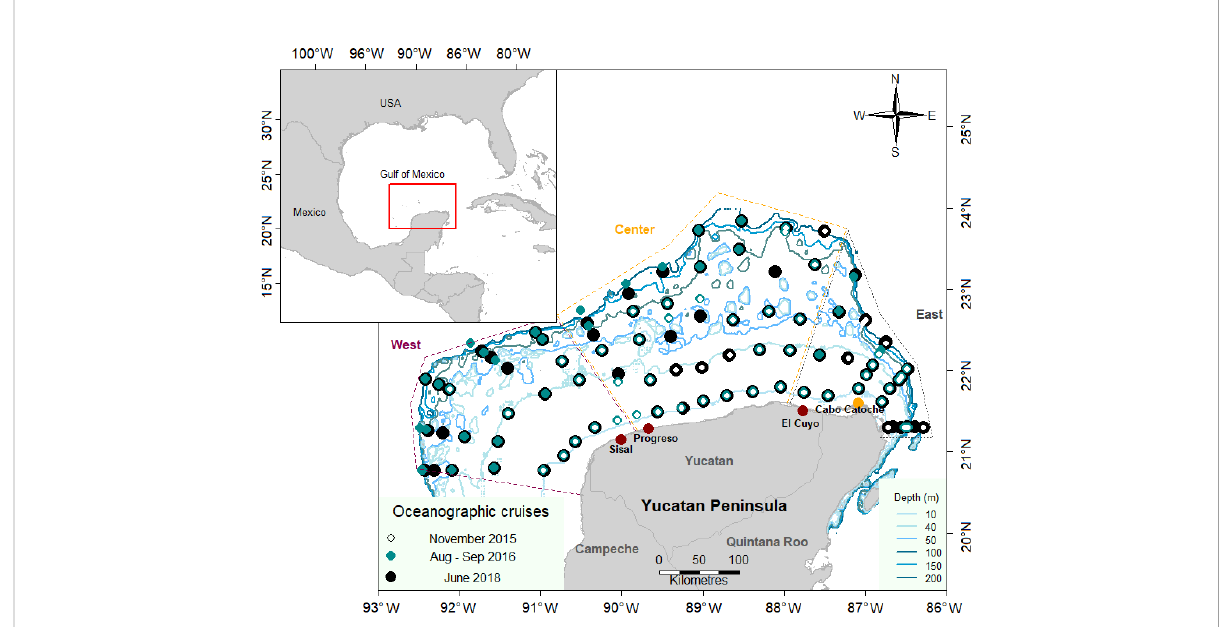
FIGURE 1 Study area and zooplankton sampling stations in the Yucatan Shelf, Southeastern Gulf of Mexico (SGoM). Red dots represent the ports where adult organisms were sampled. The dotted lines represent the three zones: Western ( — purple), Central ( — orange), and Eastern ( —